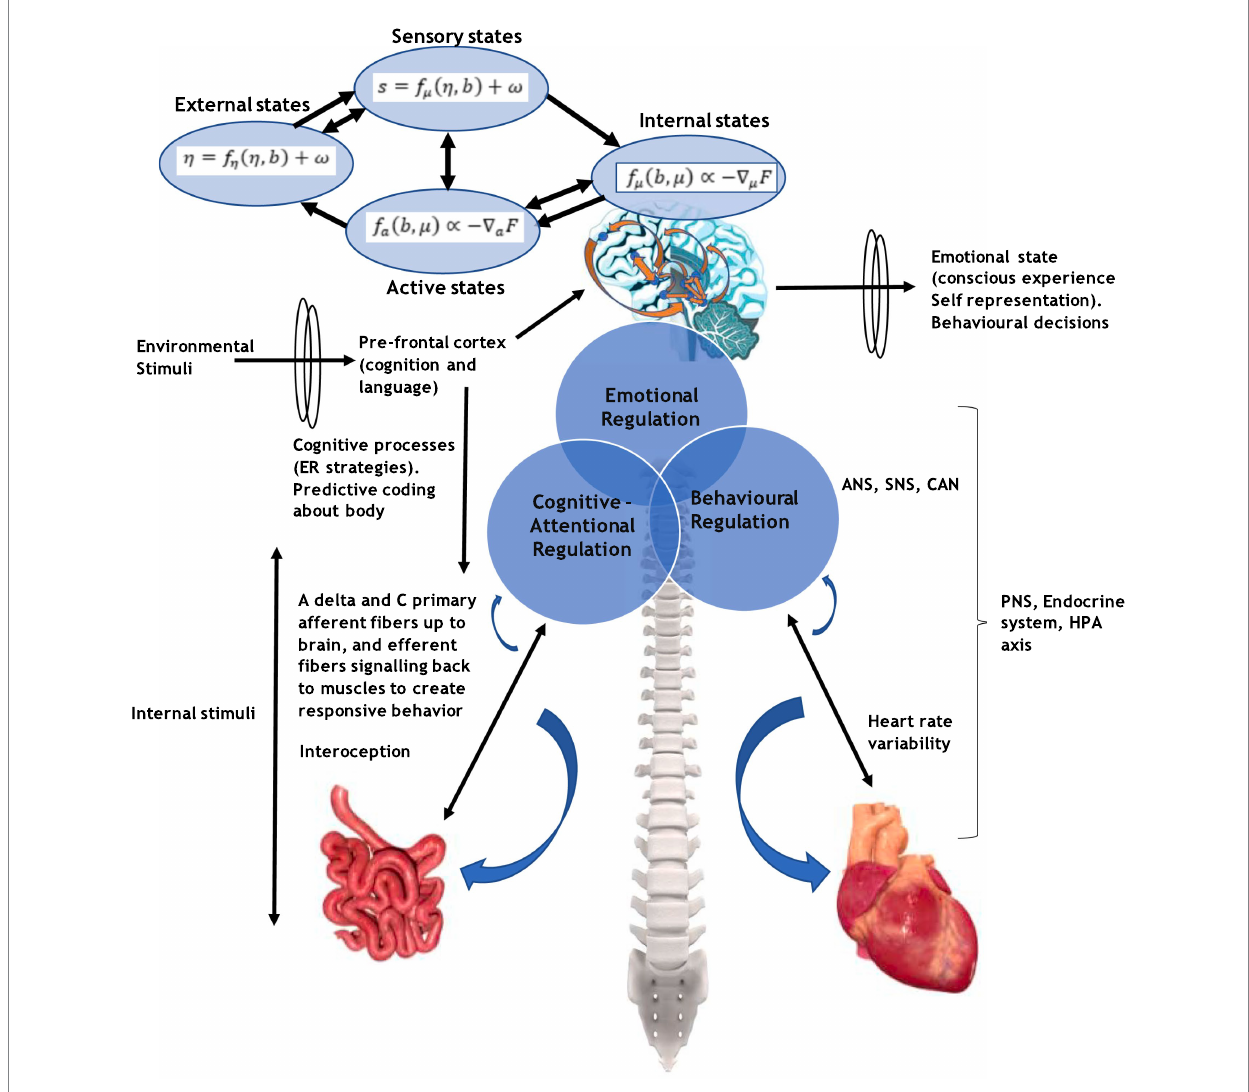
FIGURE 13 A schematic representation of the ensemble dynamics and Markov blankets, and the bottom-up and top-down relationships between interoception, parasympathetic vagal tone, and central self-regulatory